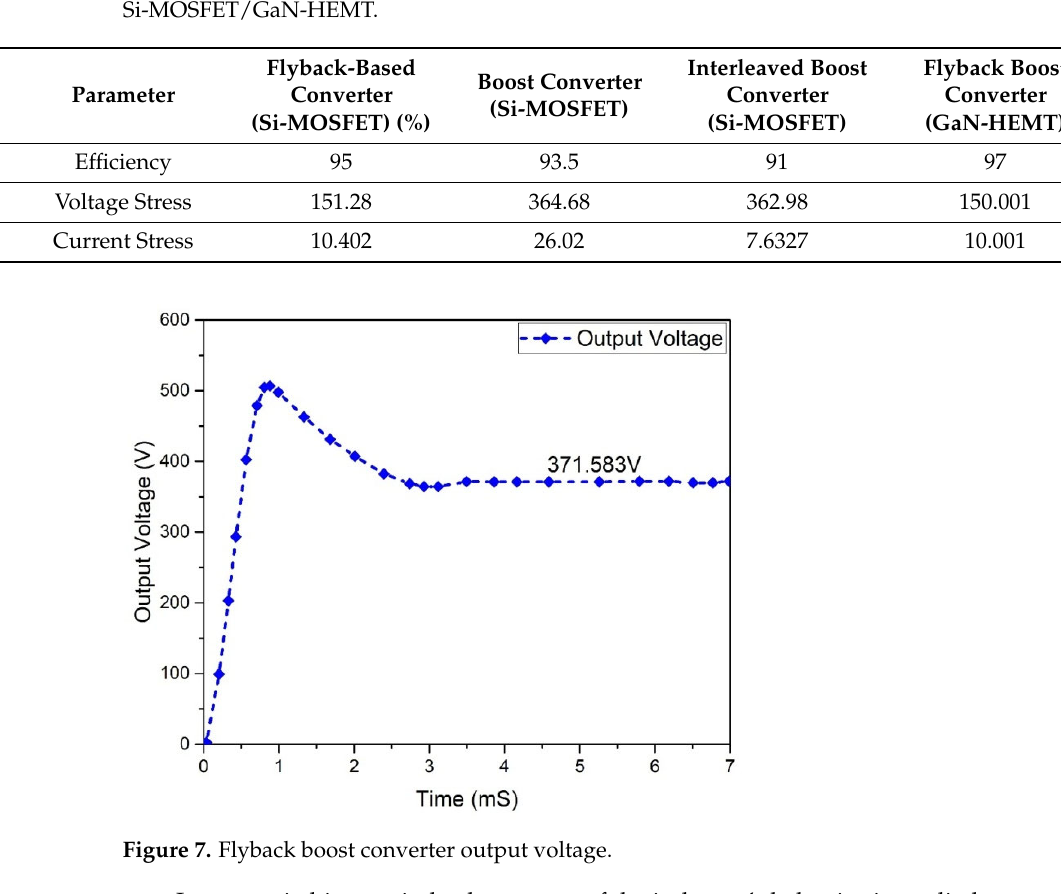
Figure 8. Input current analysis of Flyback boost converter.